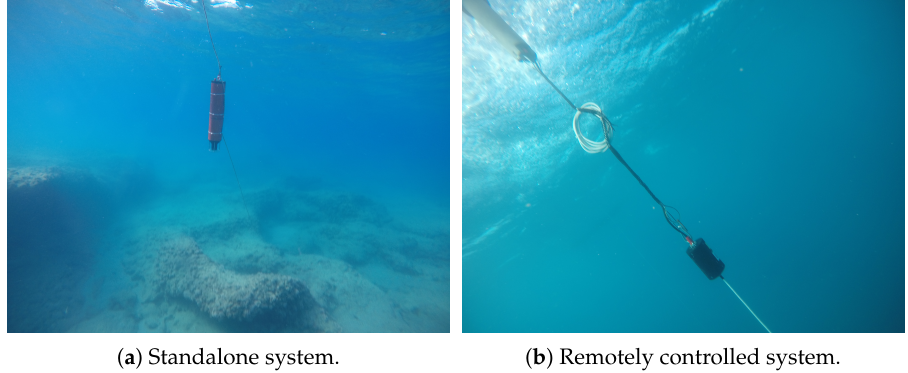
Figure 2. Pictures of the two configurations of transceiver system from two of the sea